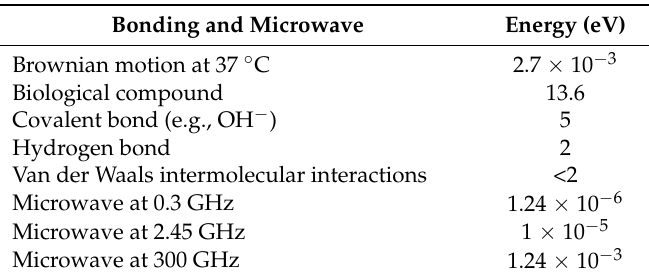
Table 4. Energy of different bonds and